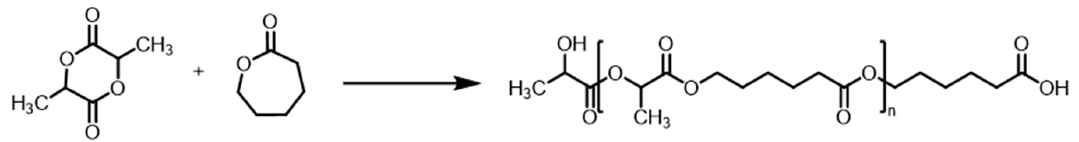
Figure 1. The synthesis of copolymers of lactide and caprolactone.